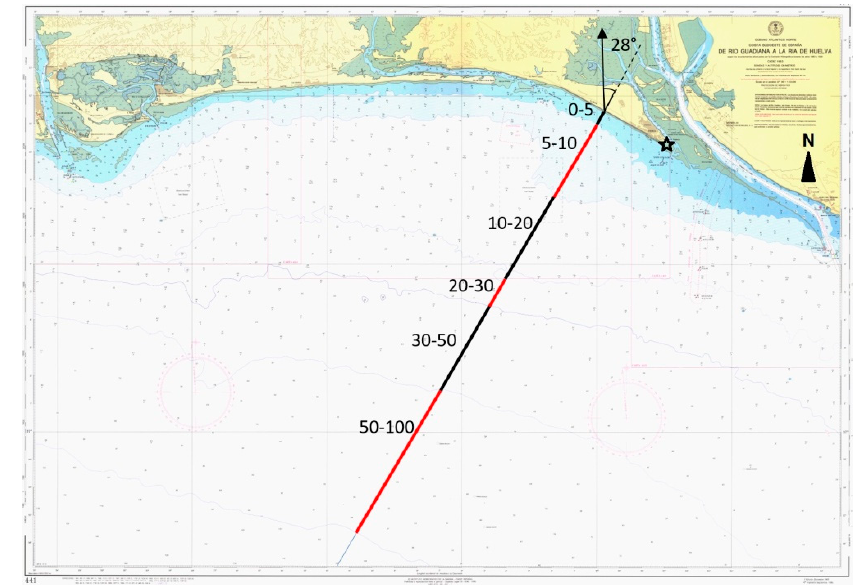
Figure 4. Transect perpendicular to Punta Umbría beach along which the topo-bathymetric profile representative of the study area has been extracted (the star indicates the location of the stranding). The red and black segments indicate the segments between the different bathymetric lines (e.g., 0–5 is the segment between the bathymetric lines 0 and 5 m).